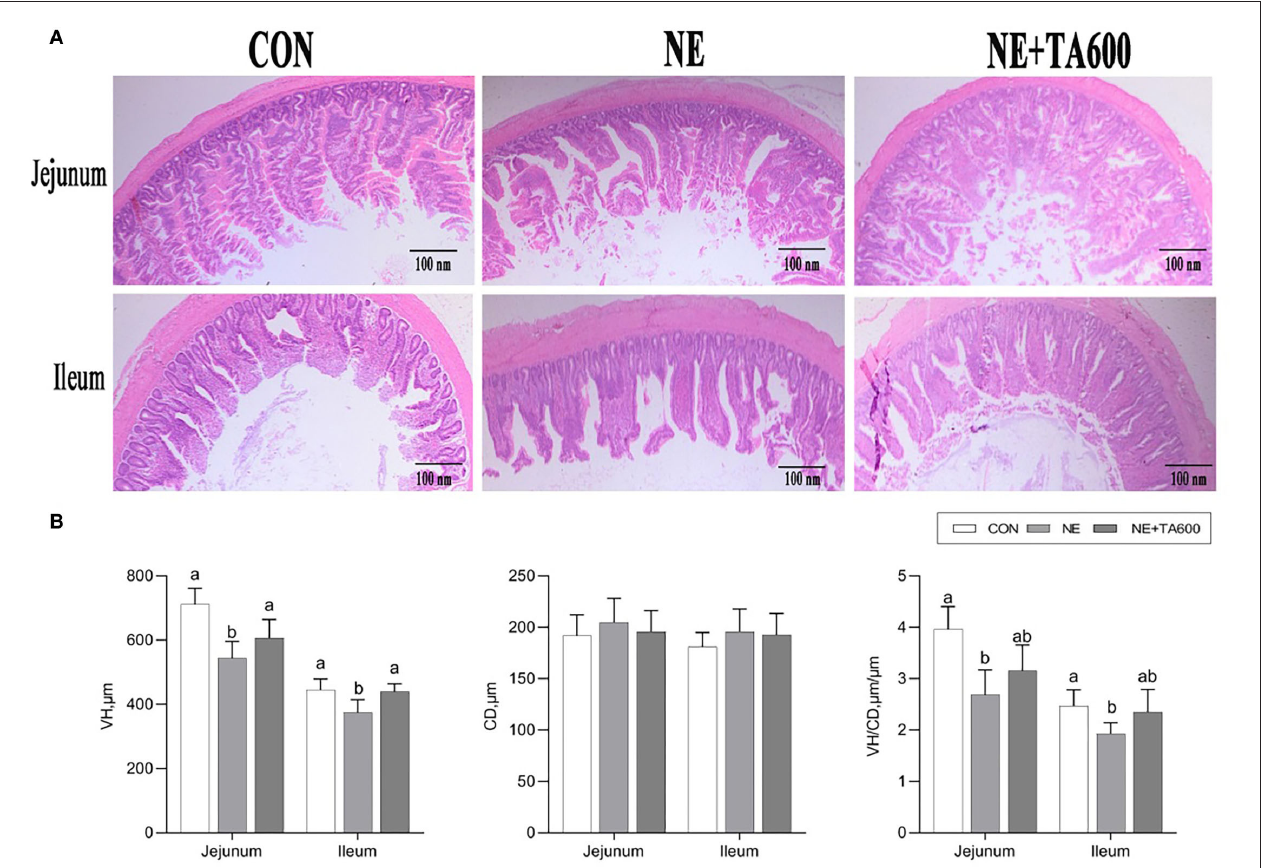
FIGURE 1 | Effects of TA on intestinal morphology of subclinical NE broilers. (A) Hematoxylin and eosin staining, (B) VH, CD, and VH/CD of the intestine. Values were expressed as mean with standard error represented by vertical bars. a,b Means with different letters differ significantly among the groups ( p < 0.05). VH, villus height; CD, crypt